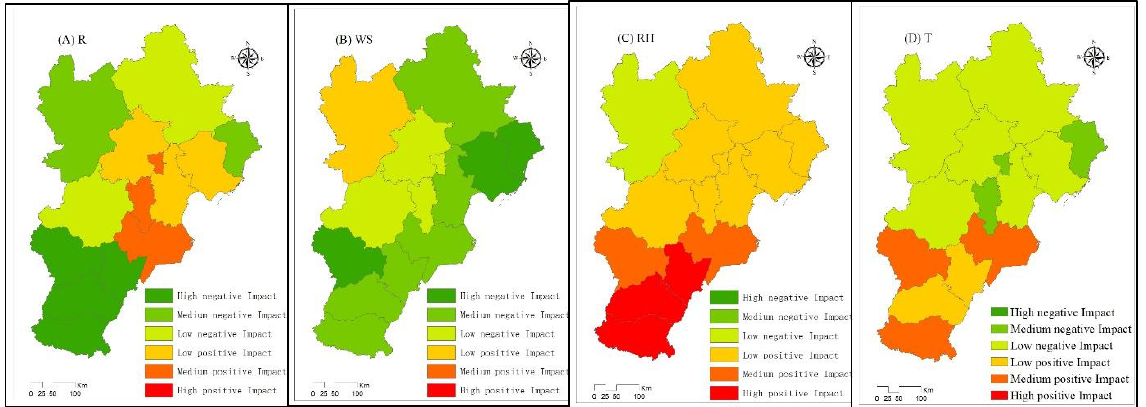
Figure 4. Spatial distribution of regression coefficients for natural factors in the Beijing–Tianjin–Hebei urban agglomeration during the study period.